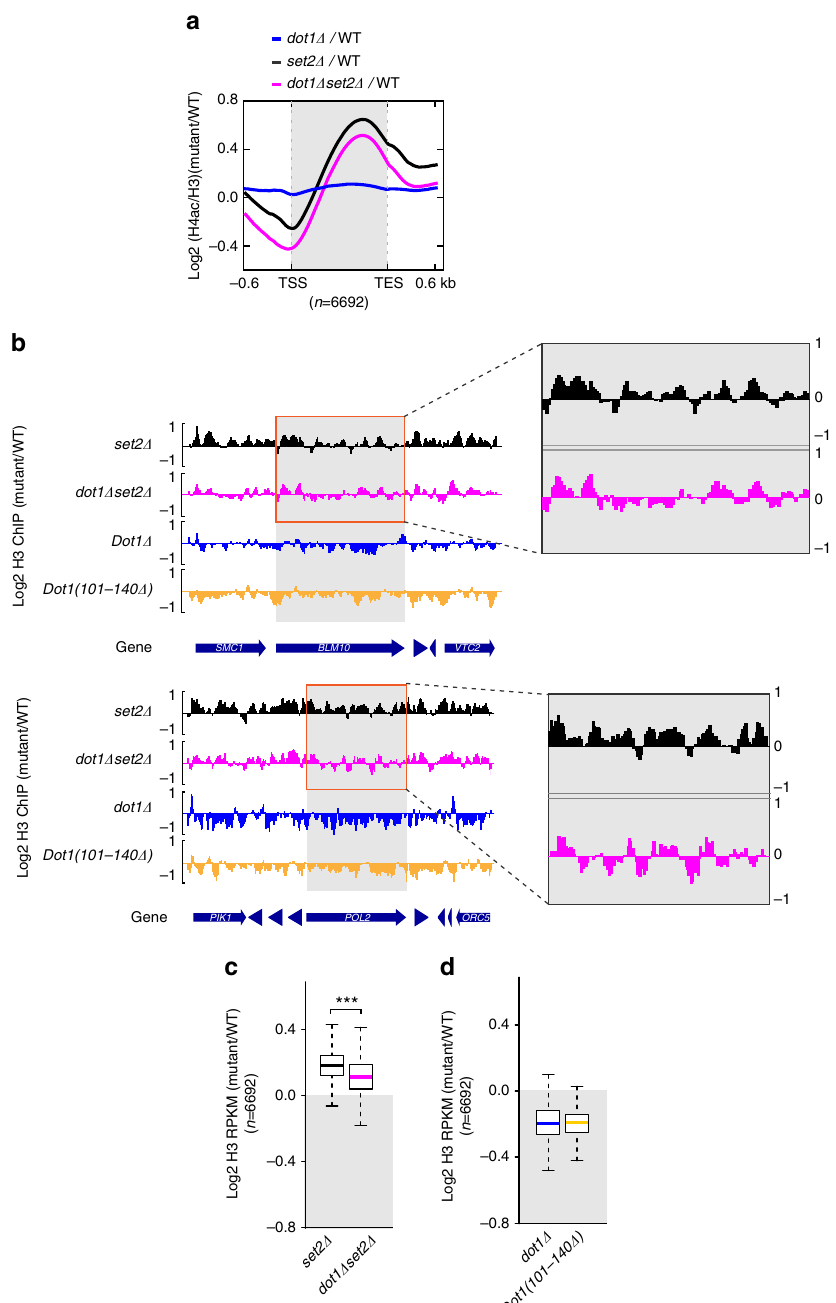
Fig. 3 Loss of DOT1 suppresses the increased histone exchange at transcribed regions in set2 Δ cells. a The ChIP-seq average plot of H4ac normalized by H3. The values for set2 Δ (black), dot1 Δ set2 Δ (magenta), and dot1 Δ (blue) cells were calculated as the log 2 ratios of the mutant over wild type. The values of the y -axis indicate log 2 fold change level of H4ac/H3 ChIP-seq in mutants over wild-type cells, and the x -axis indicates the distance from transcription start sites (TSS) and transcription end sites (TES). The data set included all transcribed regions of yeast (number of genes, n = 6692), and were obtained from biological duplicates. b Distribution of H3 at the BLM10 (left) and POL2 (right) genes. The ChIP-seq data were obtained from biological duplicates. The y- axis indicates log 2 fold change of H3 in mutants over wild type. The H3 levels were normalized as log 2 (mutant/wild-type) values using the spike-in normalization method. The plus and minus values of the y -axis indicate the increased and decreased level of each mutant with respect to wild type. The gray boxes indicate the transcribed regions of BLM10 and POL2 . The orange boxes indicate an enlarged view for BLM10 and POL2 loci. The y -axis values represent the values of zoom-up box. c A boxplot of histone H3 log 2 fold change values (normalized by the spike-in method). The y -axis indicates log 2 fold change of H3 in mutants over wild type. The values presented for set2 Δ (black) and dot1 Δ set2 Δ (magenta) are relative to the wild-type values at the transcribed regions of all yeast genes (number of genes, n = 6692). The shadowed box indicates negative values, indicating the decreased region in mutant with respect to wild-type. ***P -value < 0.001 (Wilcoxon and Mann – Whitney tests). d A boxplot of histone H3 log 2 fold change values obtained for dot1 Δ (blue) and Dot1(101 – 140 Δ ) (yellow) at the transcribed regions of all yeast genes (number of genes, n = 6692). The y -axis indicates log 2 fold change of H3 in mutants over wild type. The shadowed box indicates negative values, indicating the decreased region in mutant with respect to wild